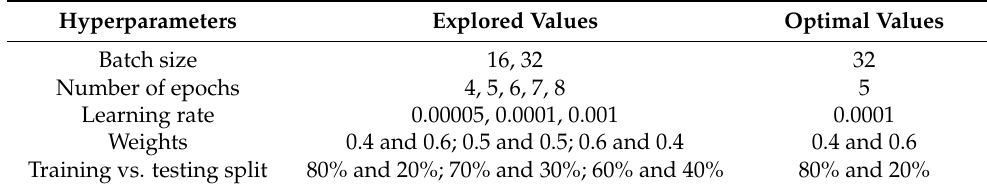
Figure 7. The classification results of the sonar video clips from the field experiments. The percent-age threshold was set for the ratio of the number of images classified as eels by the CNN to the total number of extracted images in the testing sonar video clip. Table 4. The explored hyperparameters and the optimal hyperparameters of the CNN model trained and tested on the field